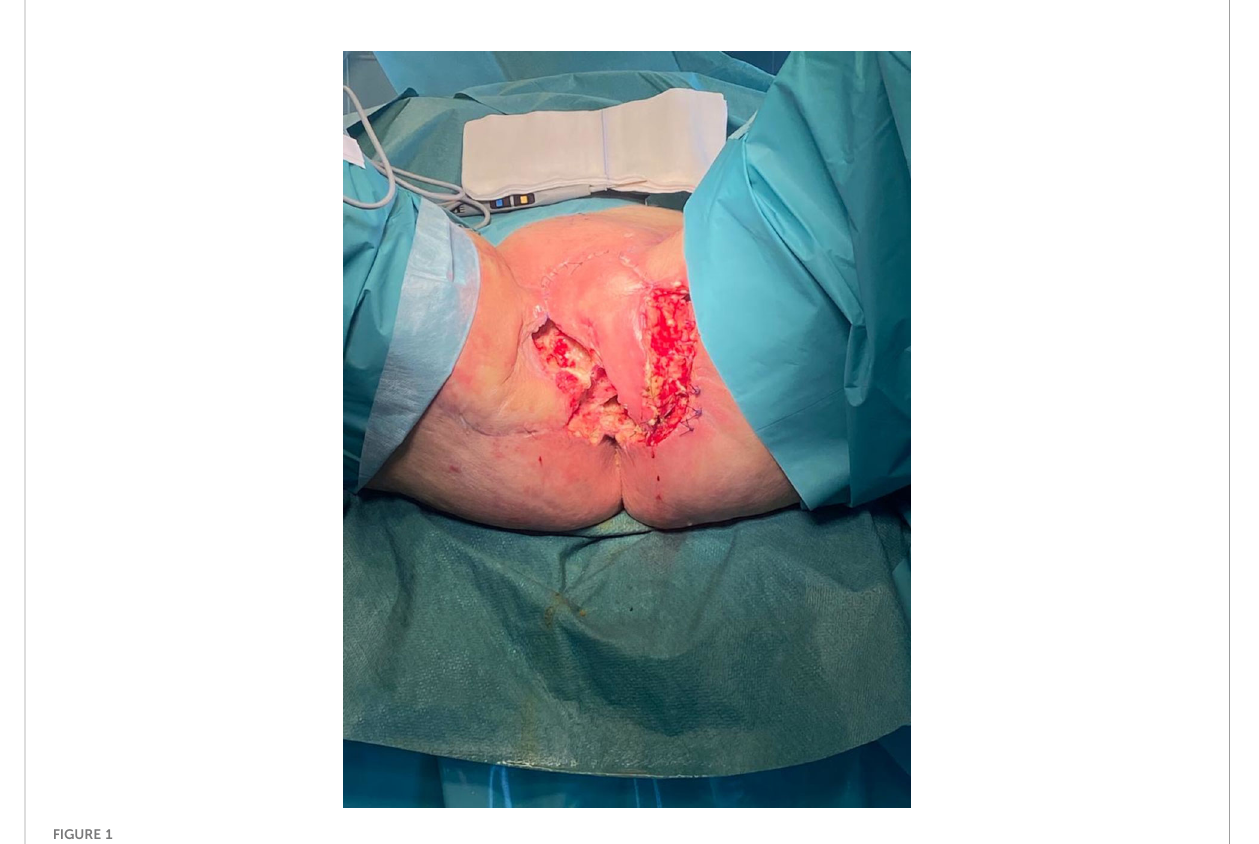
FIGURE 1 Myo-cutaneous